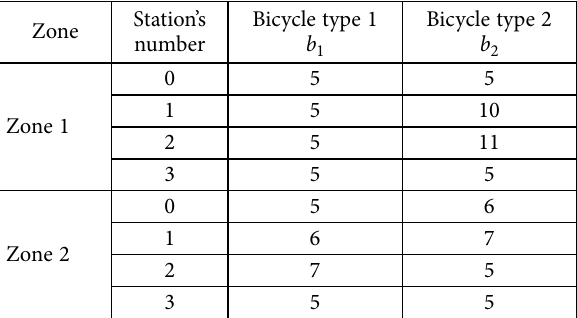
Table 8. Current inventory of each bicycle types in stations for both numerical examples